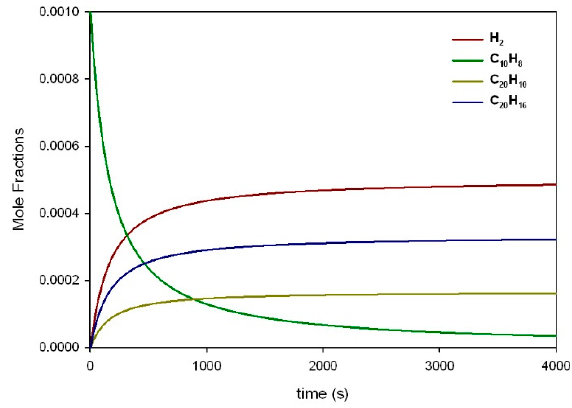
Figure 5. Pyrolysis of naphthalene at 1200 K.